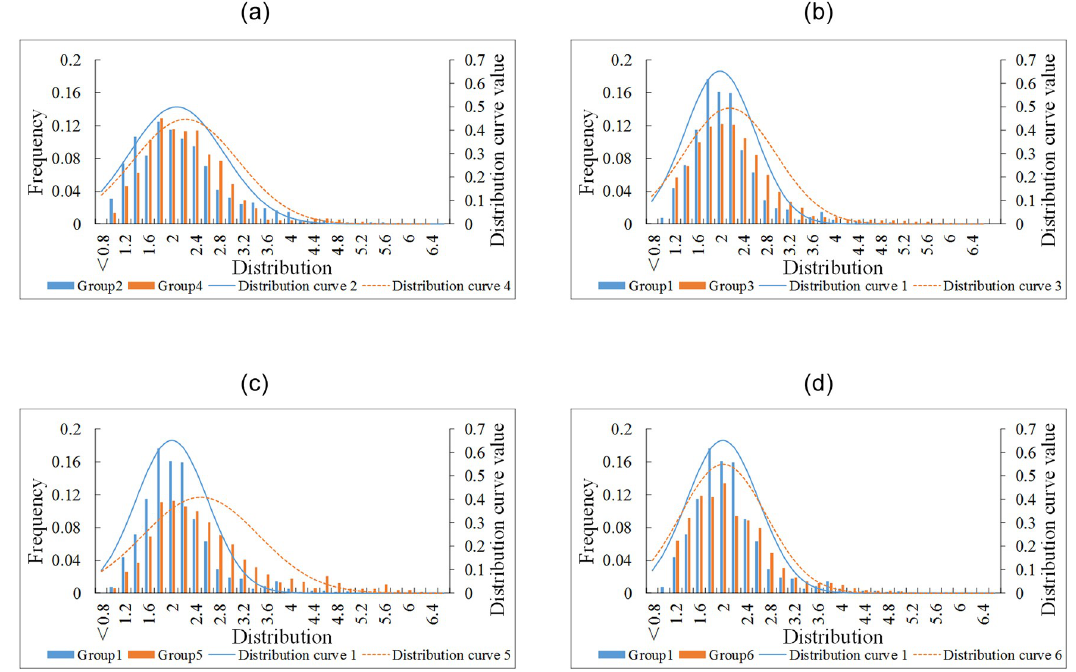
Fig 3. Distribution of saturation headways. (a) Group 4 vs Group 2. (b) Group 3 vs Group 1. (c) Group 5 vs Group 1. (d) Group 6 vs Group